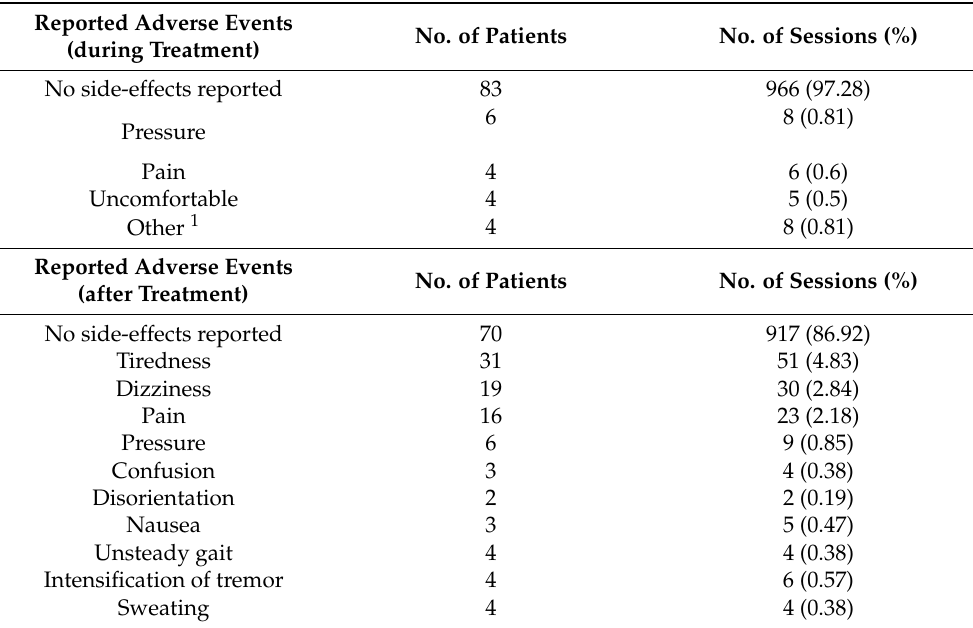
Figure 2. Adverse events during ( A , B ) and after ( C , D ). TPS treatment reported by patients across all sessions and percentage over all sessions, respectively. Detailed numbers are in Table 2.